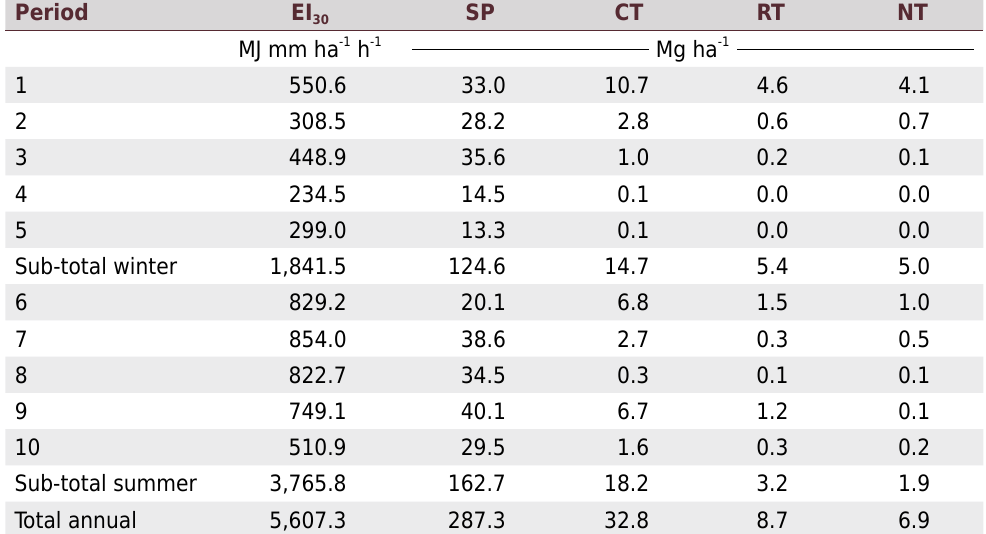
Table 2. Mean of the periods for erosivity (EI 30 ) and soil losses in the different soil management systems during 13-years of assessment. Sub total correspond the accumulated of the winter crops and summer crops